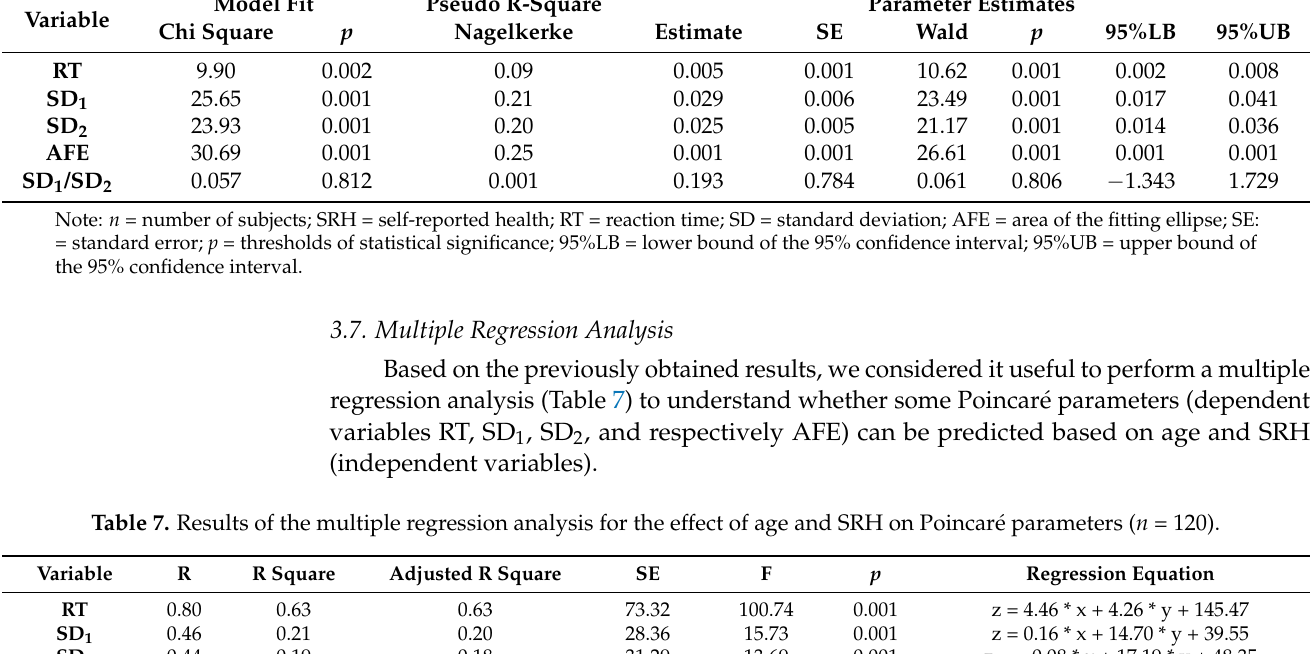
Table 6. Results of the ordinal regression analysis for the effect of Poincar é parameters on SRH ( n = 120). Model Fit Pseudo R-Square Variable Nagelkerke Chi Square